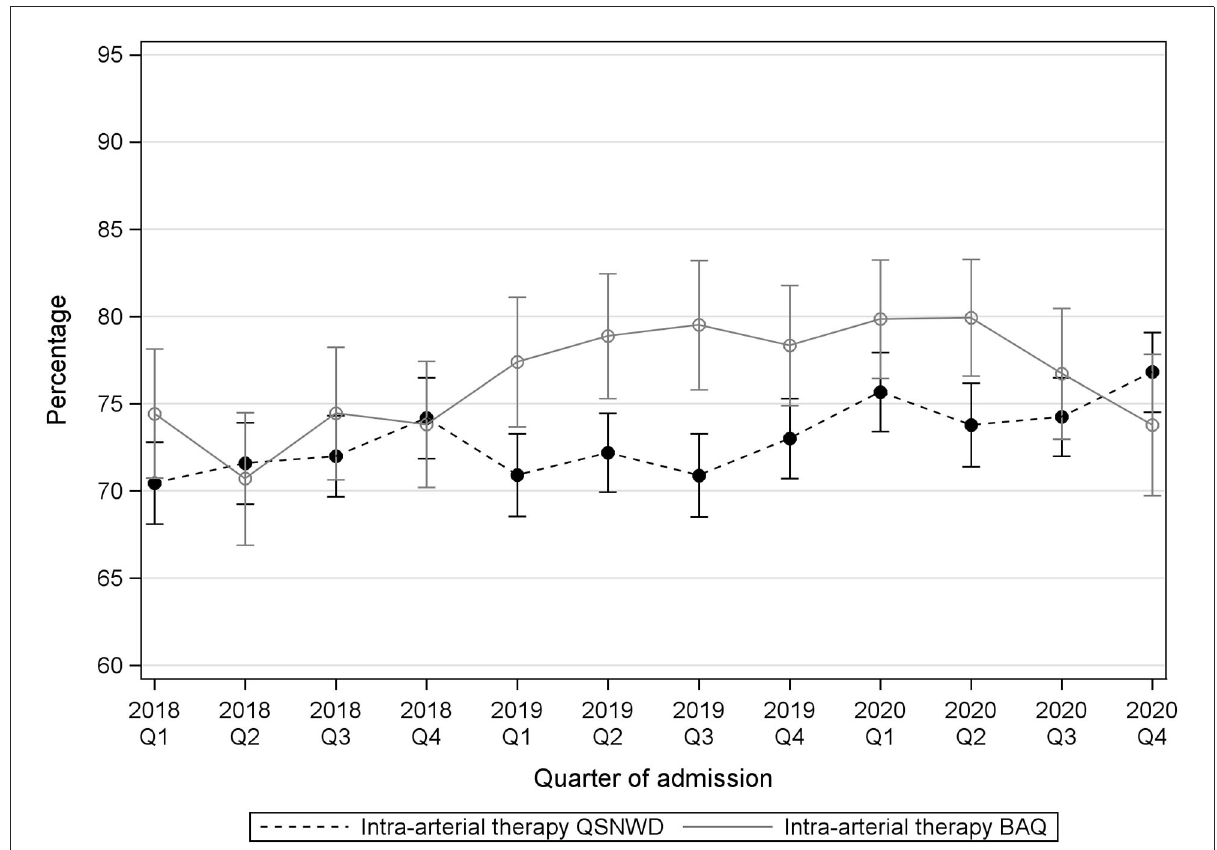
FIGURE3 Intra-arterial therapy (IAT) in patients with cerebral infarction, vessel occlusion, and a time interval event to admission of ≤ 6h or in-house stroke from the registries QSNWD (dashed line) and BAQ (solid line) in 2018-2020 by quarter of